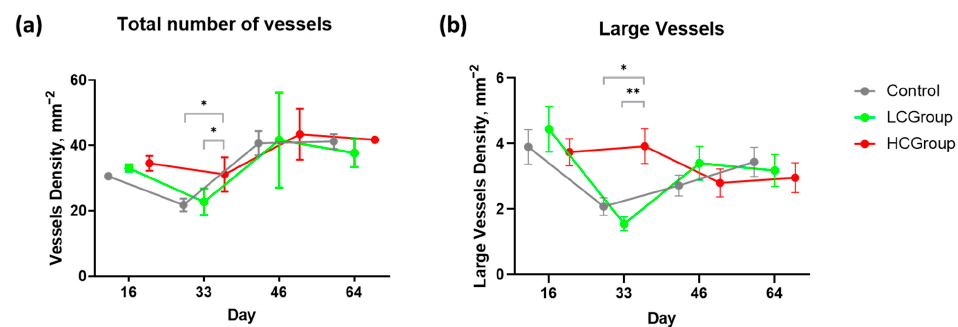
Figure 2. ( a ) Differences in the total number of blood vessels per field of view in groups and ( b ) differences in the number of large blood vessels per field of view in groups. Data presented as mean ± 95% CI. LCGroup—low-concentration group, HCGroup—high-concentration group. Note: * p < 0.05, ** p <